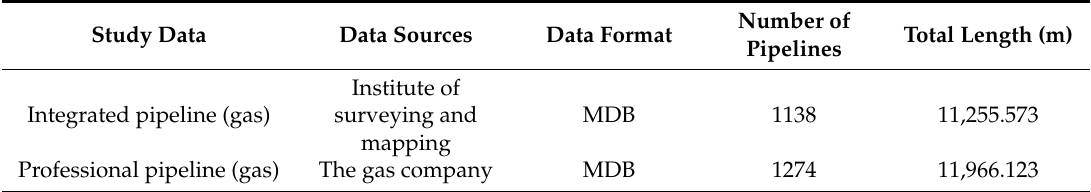
Table 1. Summary of the experimental data from the integrated and professional